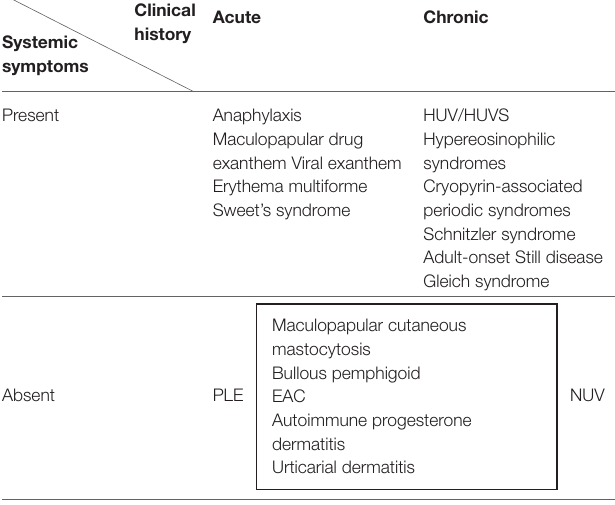
TABLE 1 | Clinical entities with acute and chronic urticarial